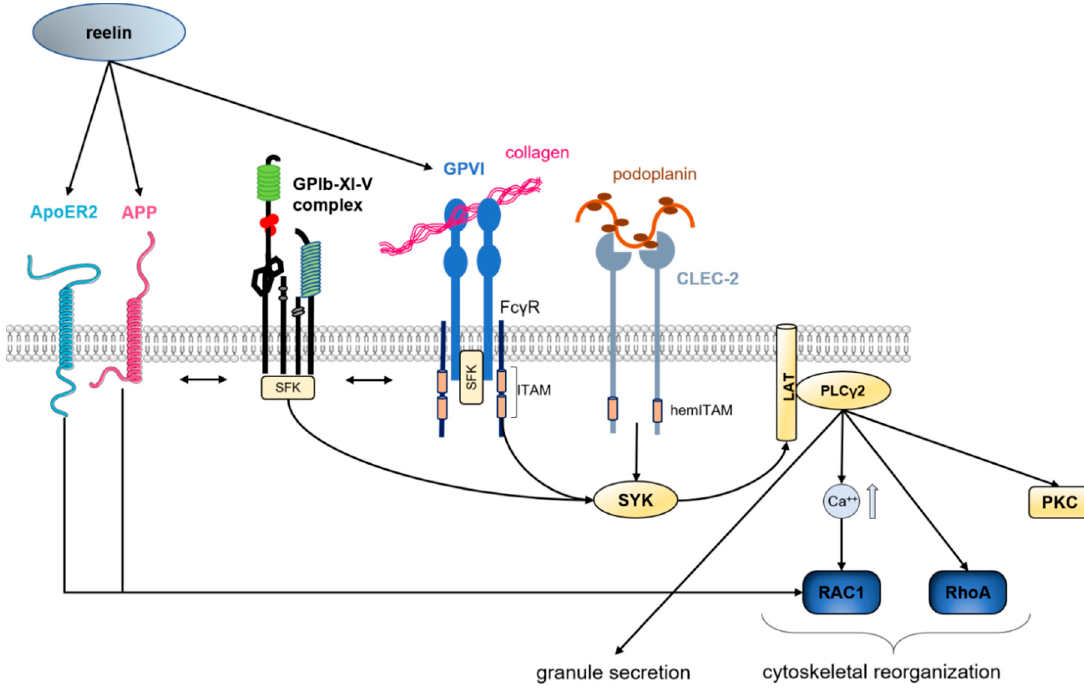
Figure 1. Impact of reelin in platelet activation and ITAM signaling. Extracellular reelin binds to ApoER2 and APP receptors at the platelet surface, resulting in platelet activation through RAC-1 activation. Additionally, reelin binding indirectly modulates GPIb signaling through APP and GPVI. Ligand binding to GPVI leads to dimerization of GPVI monomers, inducing auto-transphosphorylation of the GPVI-associated Fc γ R-chain ITAM motif through activation of Src-family kinases (SFKs). Besides, podoplanin binding to the CLEC-2 receptor causes activation of the CLEC-2-integrated hemITAM motif. Phosphorylated ITAM motifs lead to phosphorylation of SYK, which activates LAT kinases, being in direct proximity to PLC γ 2. Activated PLC γ 2 causes granule release, activation of protein kinase C (PKC), and activation of RAC1 and RhoA through calcium influx leading to cytoskeletal reorganization. This figure was created using images from Servier Medical Art Commons